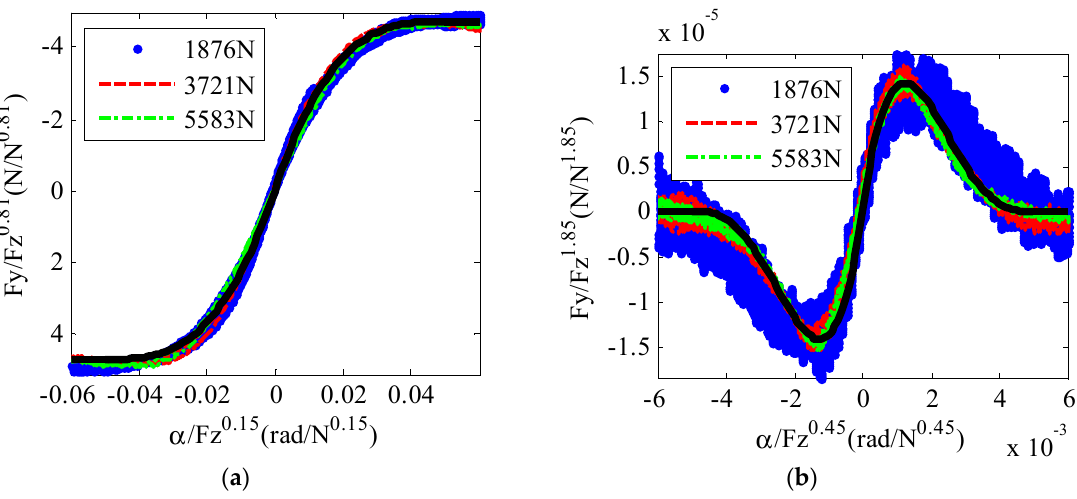
Figure 3. Normalization of tire test data with the original tire brush model: ( a ) lateral force; ( b ) self-aligning torque.